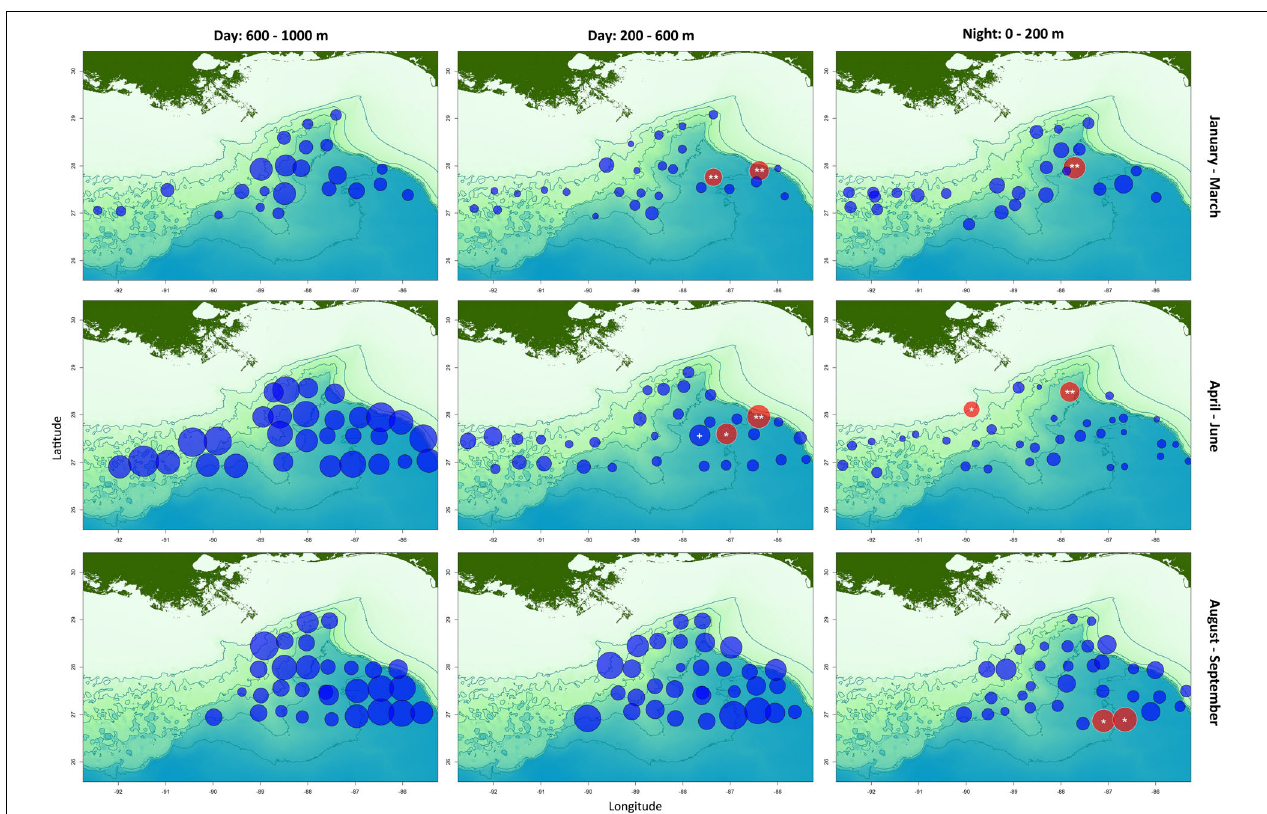
FIGURE 5 | Local contribution to beta diversity (LCBD) scores of each sample, subdivided by depth band and cruise program. Red circles indicate samples that are significantly different to the mean community; blue circles are samples that are not significantly different. The radii of the circles correspond to the LCBD scores. The significance (with Holm correction) is indicated as: + p < 0.1; * p < 0.05; ** p <